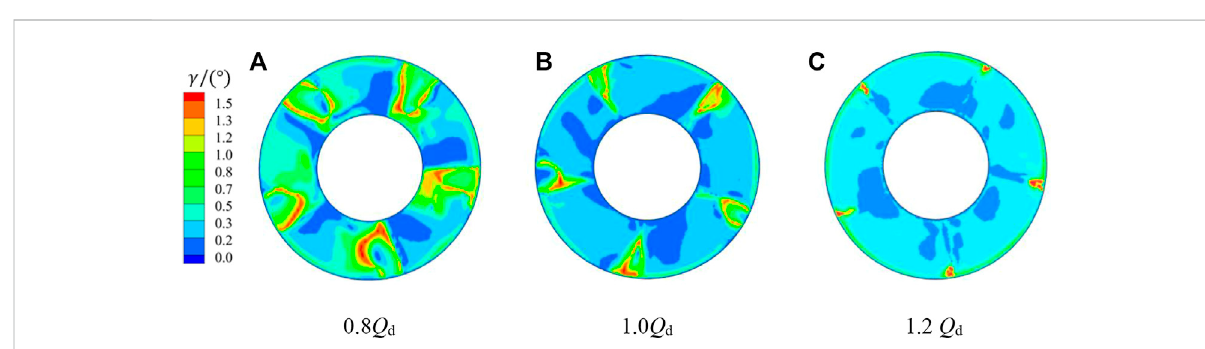
Distribution diagram of the de fl ected fl ow angle of section 1-1 under different conditions.